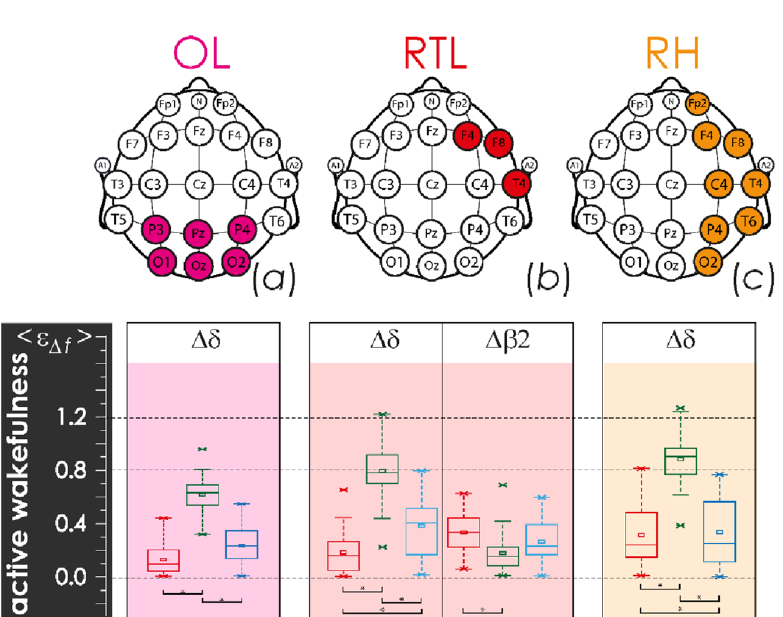
Figure 3. Distributions of the integral averages of relative CWT amplitudes, (cid:31) ε (cid:31) f (cid:30) QS , based on EEG monitoring in newborn groups I and II for the various lobes of the brain, calculated under the physiological state of active wakefulness (AW): ( a ) diagrams for the occipital lobe (OL); ( b ) diagrams for the right temporal lobe (RTL); ( c ) diagrams for the left temporal lobe (LTL). The localization of EEG channels on the scalp for each brain lobe is shown above. Red color indicates estimates for group II (EEG monitoring event GA34–37 10d ), green and blue colors code the estimates of the first and second monitoring events in group I, GA38–41 8h and GA38–41 10d , respectively. The diagrams depict the following statistical characteristics of numerical indicators: the first and the third quartiles (25–75%, inside the box), the median and the mean (transverse line and point inside the box, respectively), 1.5 interquartile ranges (shown by whiskers), and outliers represented by asterisks. At the bottom, underlining with asterisks highlights the pairs of values meeting the Mann–Whitney test with p <